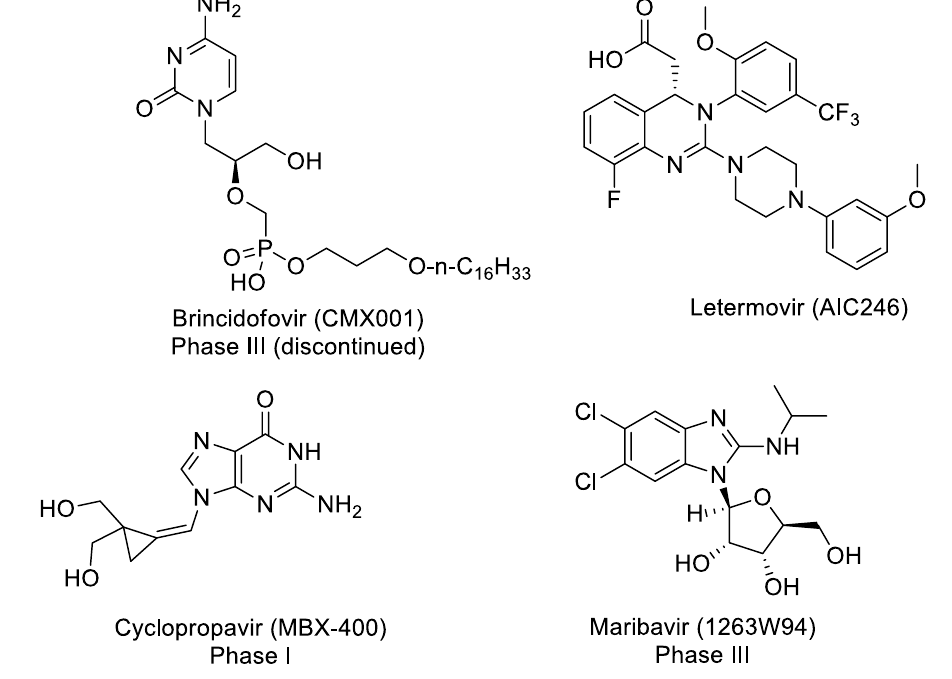
Figure 1. Recently developed antiviral agents against HCMV.